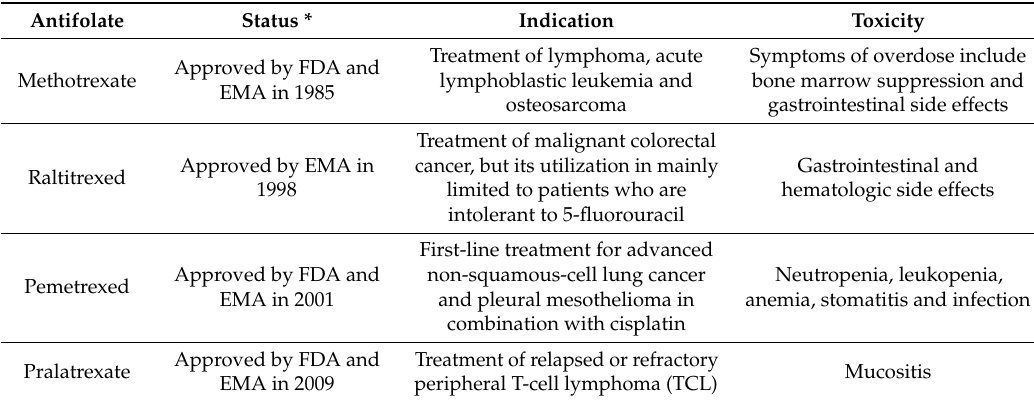
Table 1. DHFR inhibitors that have been approved